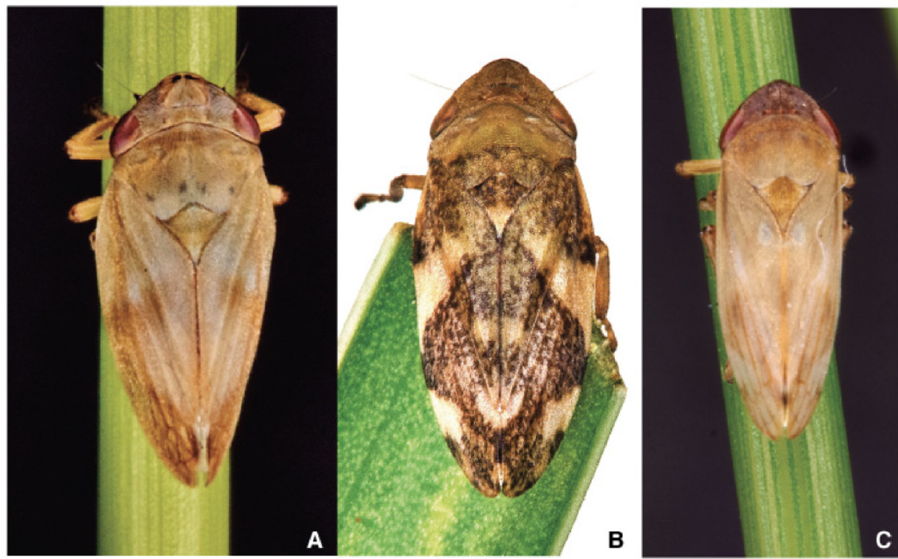
Figure 6. Adults of ( A ) Philaenus spumarius , ( B ) Philaenus italosignus , and ( C ) Neophilaenus campestris . P. spumarius is the main vector for Xylella fastidiosa subsp. pauca in Salento. (Reproduced from [103]). In Apulia, the juvenile stages of P. spumarius (i.e., nymphs) for their feeding activity prefer plant species of families such as Asteraceae ( Sonchus , Crepis , Picris ), Fabaceae ( Medicago , Vicia , Lathyrus ), Rubiaceae ( Galium ), and Apiaceae ( Daucus , Foeniculum ), with G. album and F. vulgare as preferred species. Other species were found to be “non-preferred” or “avoided”, namely Poaceae ( Avena, Lolium , Hordeum ), Brassicaceae ( Raphanus ), Papaveraceae ( Papaver ), Fumariaceae ( Fumaria ), and Oxalidaceae ( Oxalis ) [69]. It should be noted that the juvenile stages of the vectors do not transmit the bacterium; rather, it is acquired and spread by the adults when an already infected plant is reached [69]. These findings are confirmed by detection analysis surveys performed on wild and cultivated plant species potentially infected by the bacterium that did not reveal its occurrence in the preferred plants for the nymphs of P. spumarius [4], even though it would seem that the very common weed Chenopodium album as well as Erigeron spp. could host the pathogen through the feeding activity of the adult vectors [69]. Egg hatching and naiad development occur within the temperature range between 2.8 and 10 ◦ C, and nymphal development is observed at 27 ◦ C [106]. The density of the nymphs in the olive groves is quite high, reaching 10–40 individuals per square meter [105], explaining the high potential of pathogen vector transmission when the adult stage has been reached [107]. In the olive groves, P. spumarius adults occur from late April to late autumn. They were detected as positive for X. f . subsp. pauca in early May, and their incidence was found to be higher throughout the spring season when they efficiently spread the bacterium among the olive trees [104,106]. The peak of occurrence in the olive crown was recorded in May and June, whereas the adults preferred afterward to move toward the surrounding wild shrubs and trees [105,106]. During the period of high abundance, the adult dispersal within the olive grove can range from 200 to 400 m [106], and the colonization of other plant species occurs mainly during the summer. In autumn, adults colonize herbaceous species for ovideposition [106] (Figure 7). It has been estimated that a single infected olive tree can spread the bacterium to 19 other susceptible hosts per year